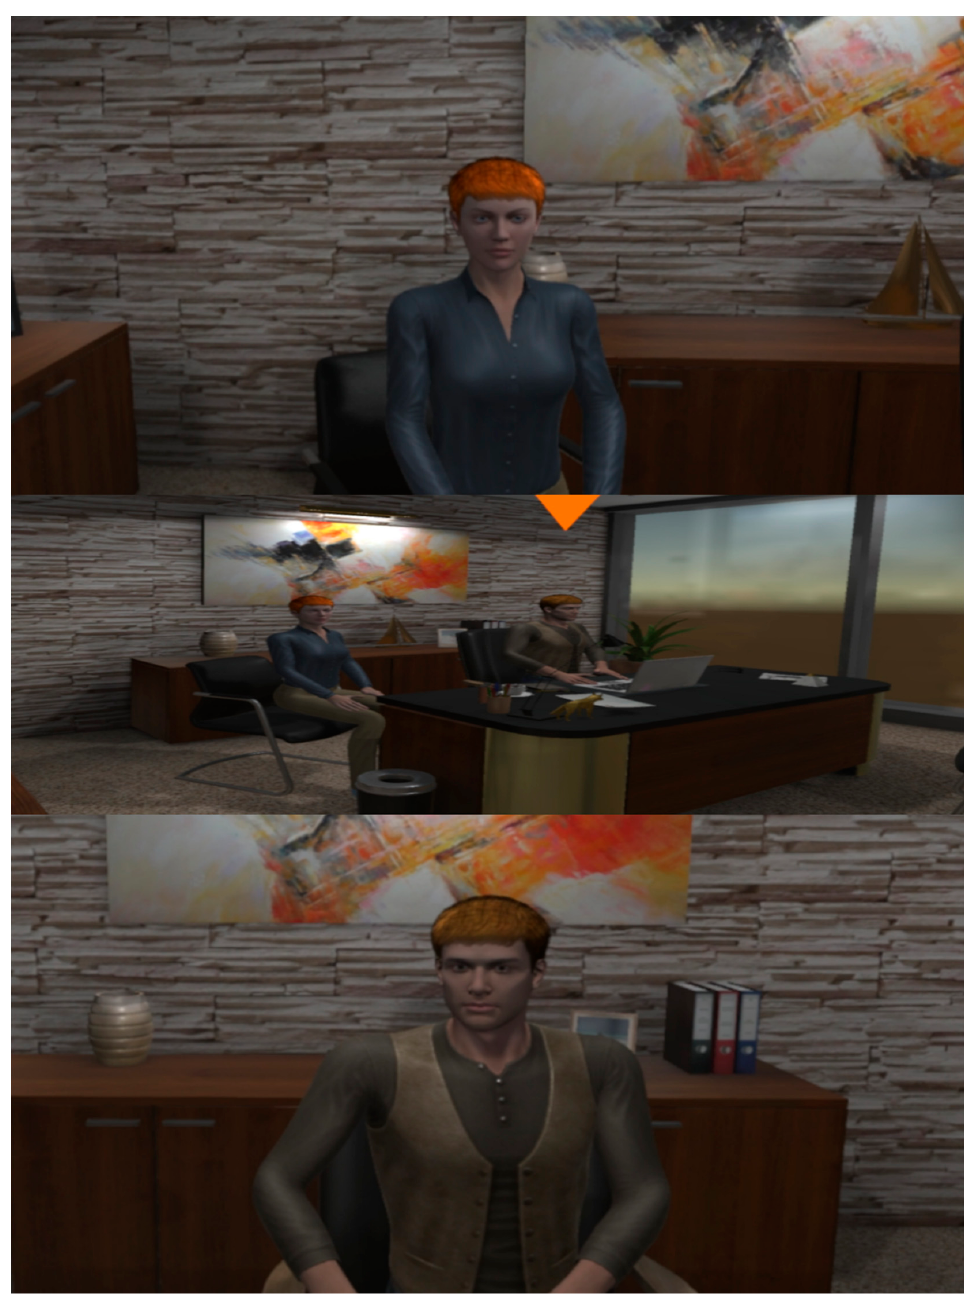
Figure 7. The HR manager ( Top ), main area ( Middle ), and team leader ( Bo tt om ) of the o ffi